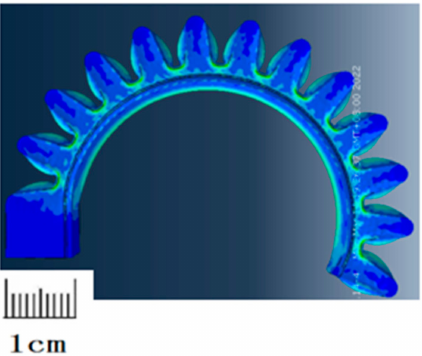
Figure 6. Diagram of increasing pressure drum in soft